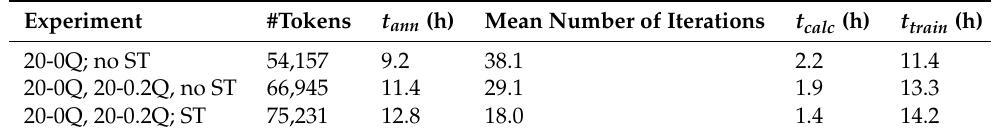
Table 4. Comparison of the overall time ( t train ) required to train the model to an F1-score of 0.885, for three different training experiments. This overall time was estimated as the sum of the annotation time ( t ann ) plus the calculation time ( t calc